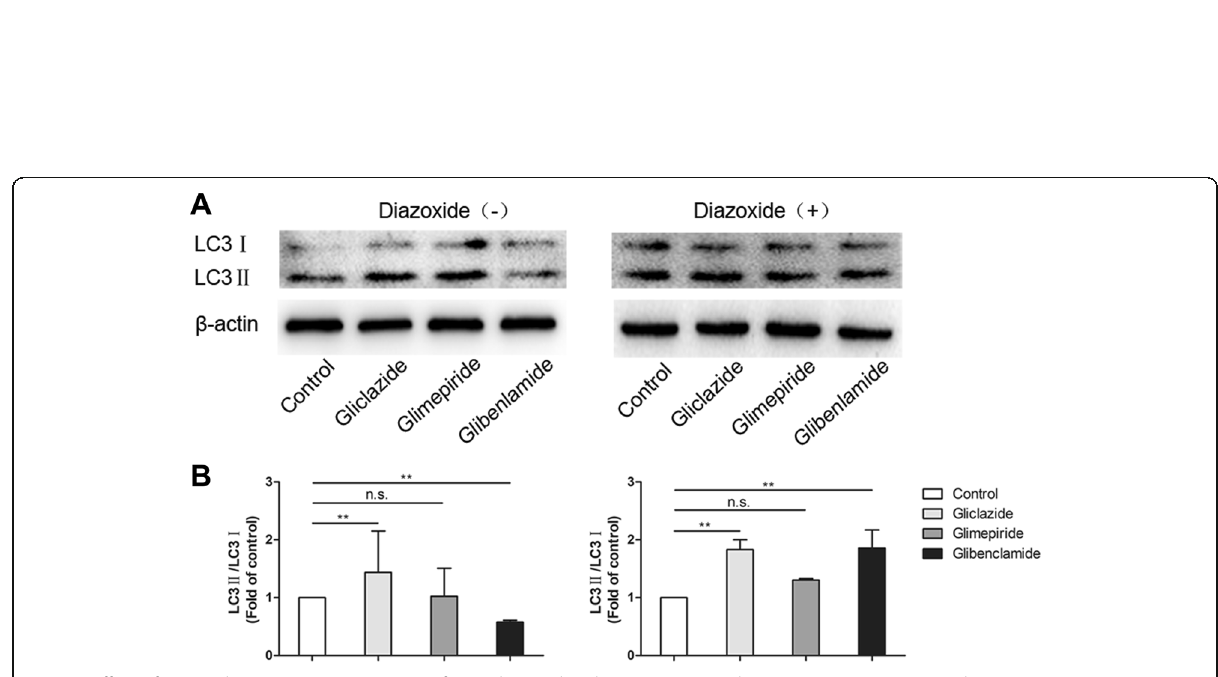
Fig. 3 . Effect of SUs and SUs + DZ on expression of autophagy-related protein. LC3I and LC3II expression in SUs and SUs + DZ groups. a Western Blot analysis of cells extracts confirmed almost complete loss of LC3I to LC3II conversion after treated with DZ. b Quantificaton of Western Blot results. Mean ± SD of three independent experiments * P < 0.05 versus control, ** p < 0.01, n.s. not significant